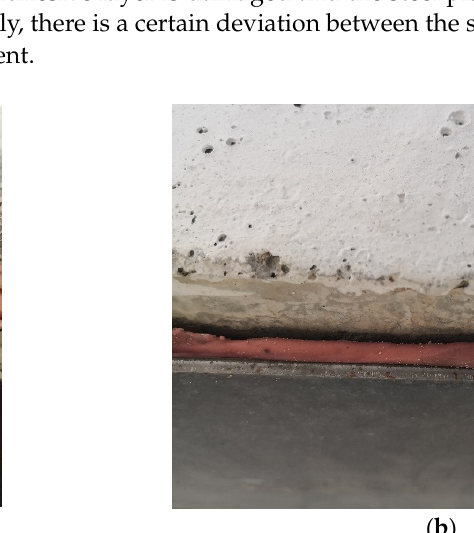
Figure 8. The crack mode in different specimens. ( a ) Unstrengthened specimens; ( b ) Strengthened specimens.